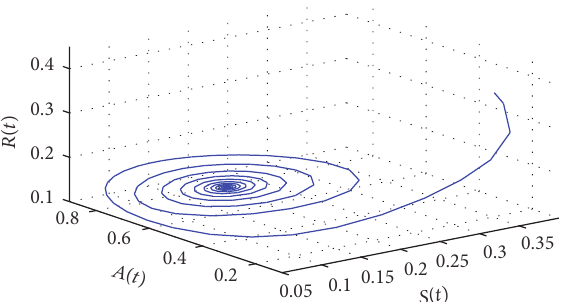
Figure 13: The phase plot of states 𝑆 ∗ , 𝐴 ∗ , and 𝑅 ∗ with 𝜏 1 = 8.65 < 𝜏 = 65.25 . 18.6255 = 𝜏 󸀠 2 10 and